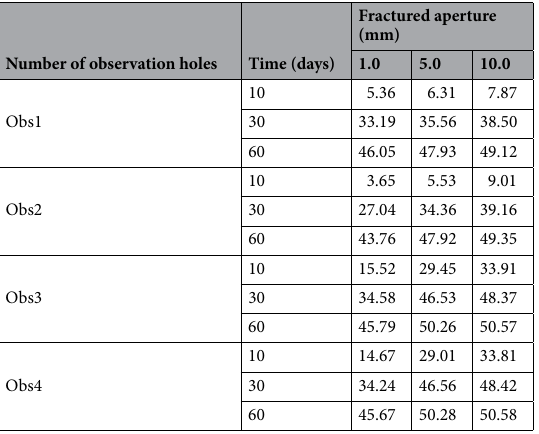
Table 6. Relationship of solute concentration and fractured